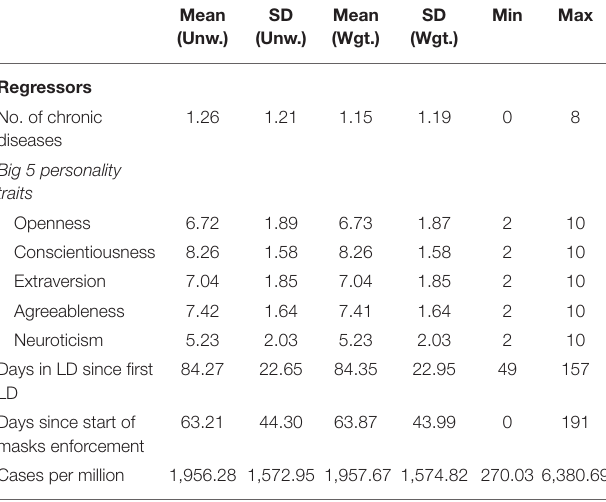
TABLE 1 | Descriptive statistics of the analytical sample for categorical variables. Frequency in sample